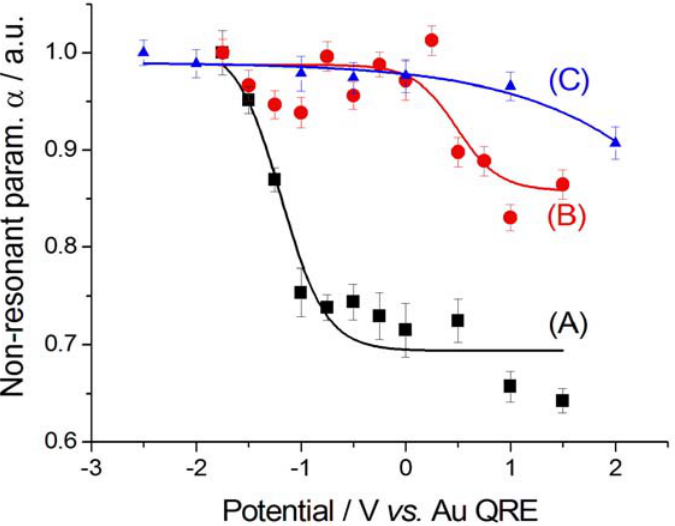
Figure 10. Non-resonant parameter  for Au in contact with [BMP][TFSA] containing 1 mM CTDB without (A, B) and with (C) 25 mM K[Au(CN) SFG spectra (see Figure 2); ( B ) Anodic-going scan, DFG spectra (see Figure 3); ( C ) Anodic-going scan, DFG spectra (see Figure 4). The error bars correspond to estimated 95% confidence